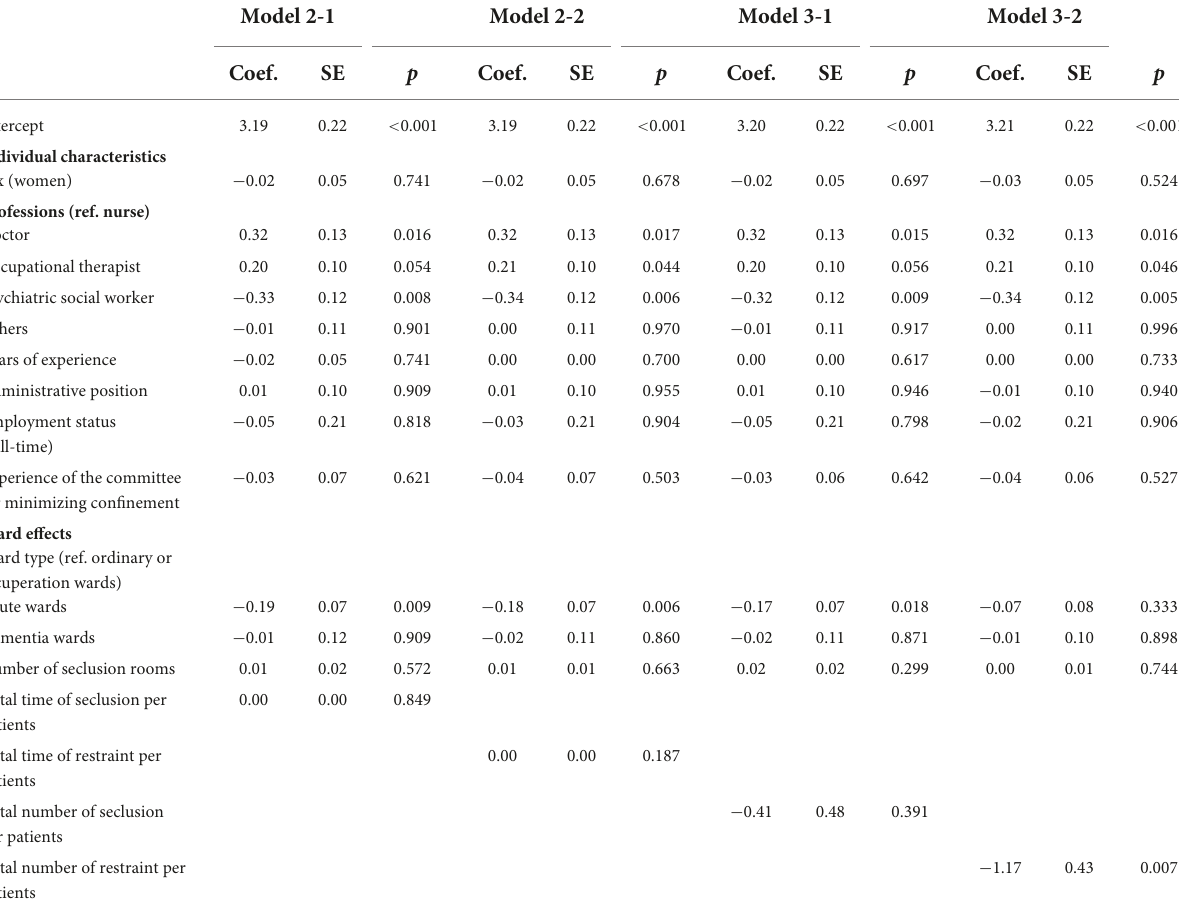
TABLE 4B Associations between the SACS score and duration and frequency of seclusion/restraints administered in a ward using multilevel linear regression analyses ( N = 255, 17